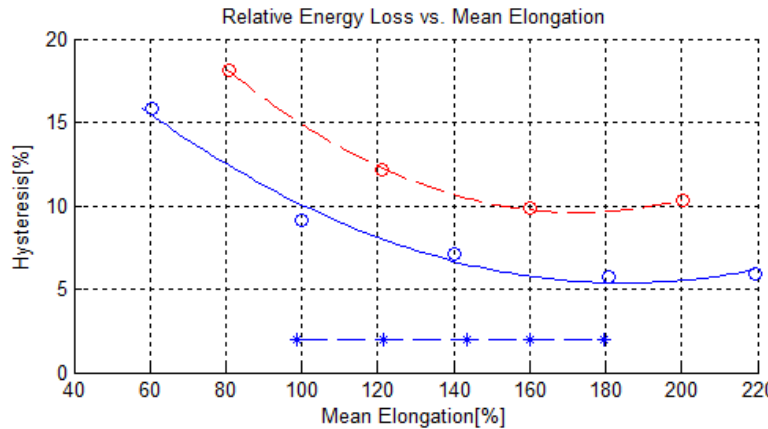
Figure 4. Relative hysteresis versus mean elongation exhibited in a load cycle. Asterisks mark natural rubber load cycles. Red circles present nitrile rubber at elongation range 80%. Blue circles present nitrile rubber at elongation range 40%. Lines are parabolic fits.